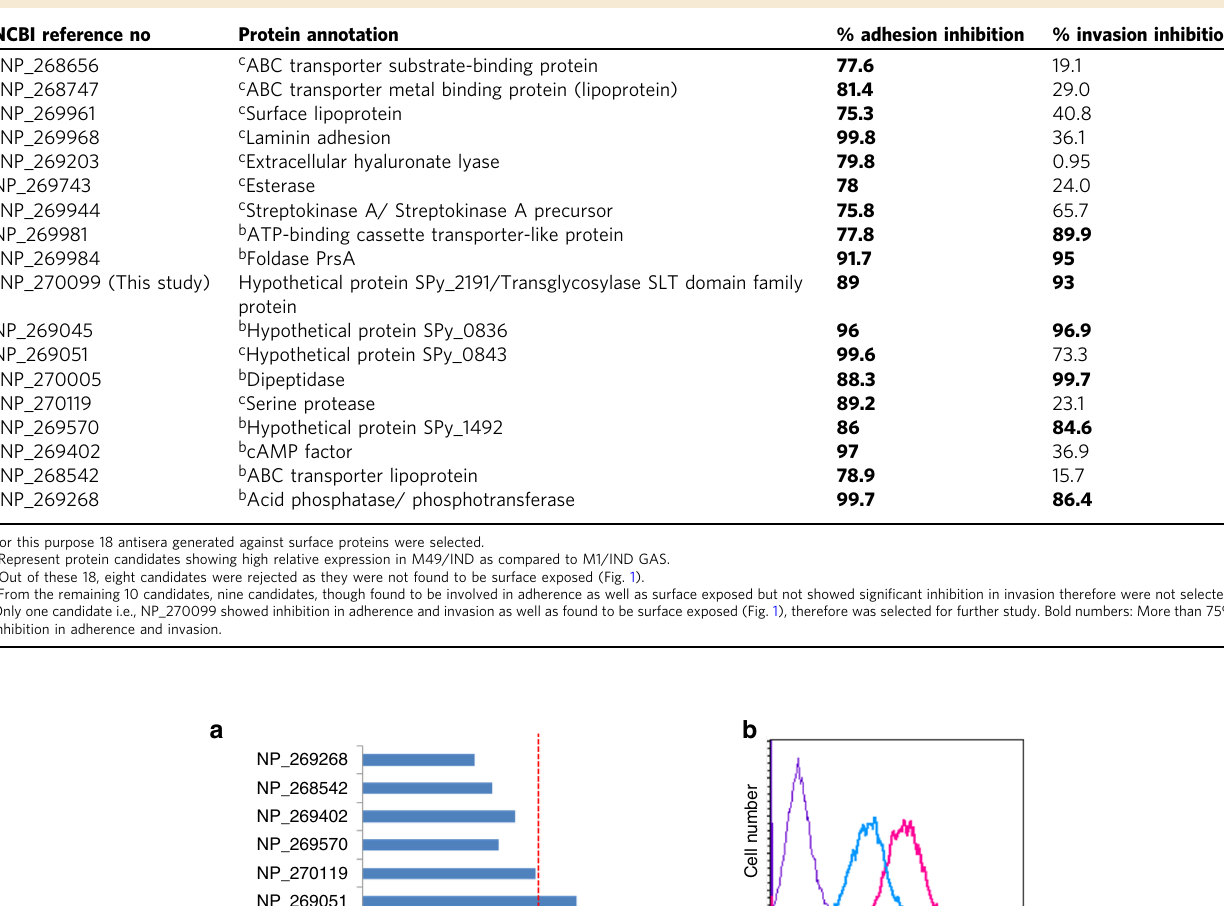
Table 1 Neutralization assay showing inhibition of GAS M49 adherence and invasion to HEp-2 cells.